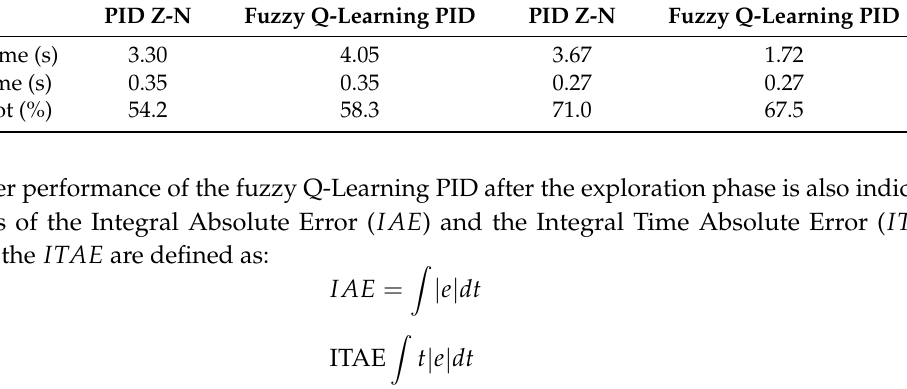
Figure 7. (cid:1835)(cid:1846)(cid:1827)(cid:1831) of conventional PID control strategy (blue line) and fuzzy Q-Learning PID control strategy (red line).